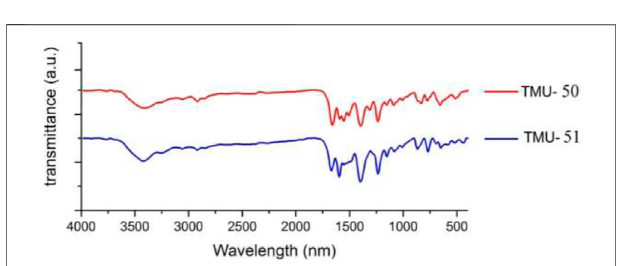
FIGURE 4 | IR spectroscopy of the TMU-50 (red) and TMU-51 (blue).